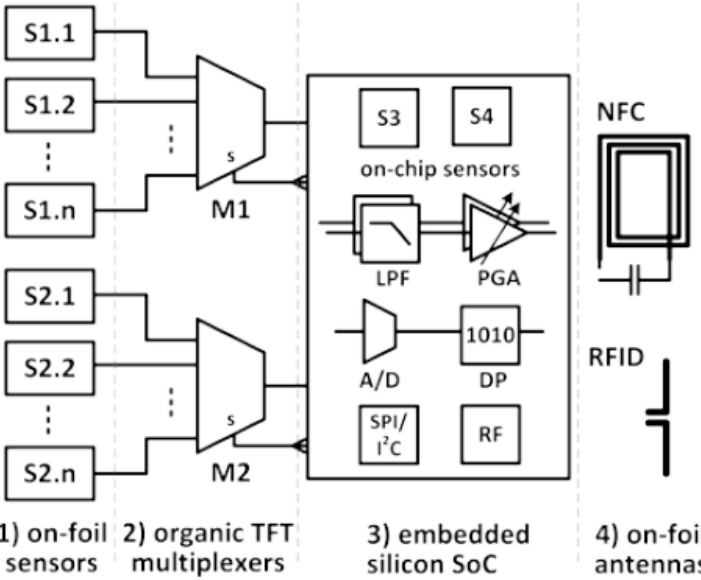
Figure 1. Schematic of the HySiF components, namely on-foil sensors, organic TFTs, ultra-thin silicon system-on-chip and antennas.